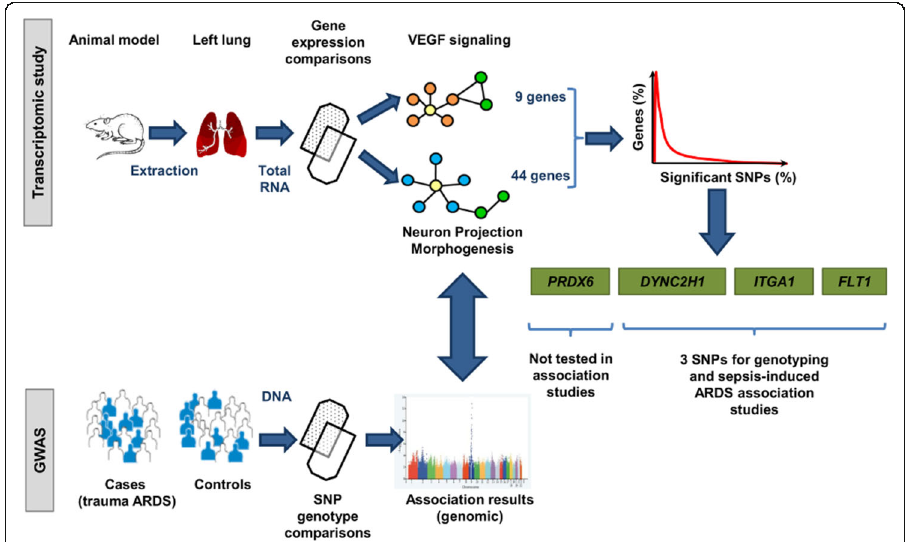
Fig. 1 Schematic representation of study procedures for gene prioritization for case-control association studies with ARDS susceptibility. Total RNA from left lung tissue from surviving animals of a rodent model of ARDS was used to perform gene expression comparisons among three experimental groups on different mechanical ventilation (MV) strategies. These analyses revealed neuron projection morphogenesis and signaling by vascular endothelial growth factor (VEGF) as differentially deregulated pathways, as well as in independent human genomic data. Among the genes contained in both pathways (9 and 44 genes, respectively), only those with at least one significant SNP ( p value ≤ 0.01) in the GWAS of ARDS were prioritized: dynein cytoplasmatic 2, heavy chain 1 ( DYNC2H1 ), fms-related tyrosine kinase-1 ( FLT1 ), integrin, alpha-1 ( ITGA1 ), and peroxiredoxin-6 ( PRDX6 ), the latter was excluded for association analyses because the top SNP was monomorphic in the discovery